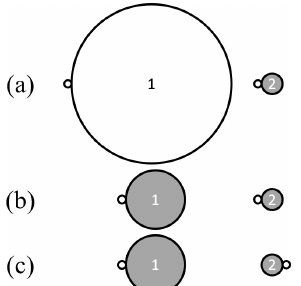
Figure 3. Position of the point charge on the surface of colliding particles depicted by a small open circle. Panel (a) shows an ice particle (1) and a small oxide particulate (2), and panels (b, c) show two oxide particles (1 and 2).